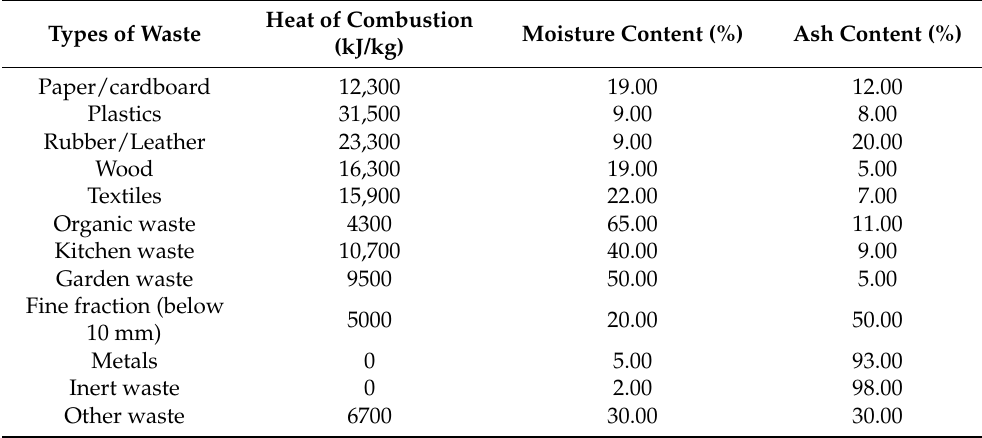
Table 8. Typical heat of combustion and the average content of moisture and non-flammable sub- stances (ash) in selected components of municipal waste (private